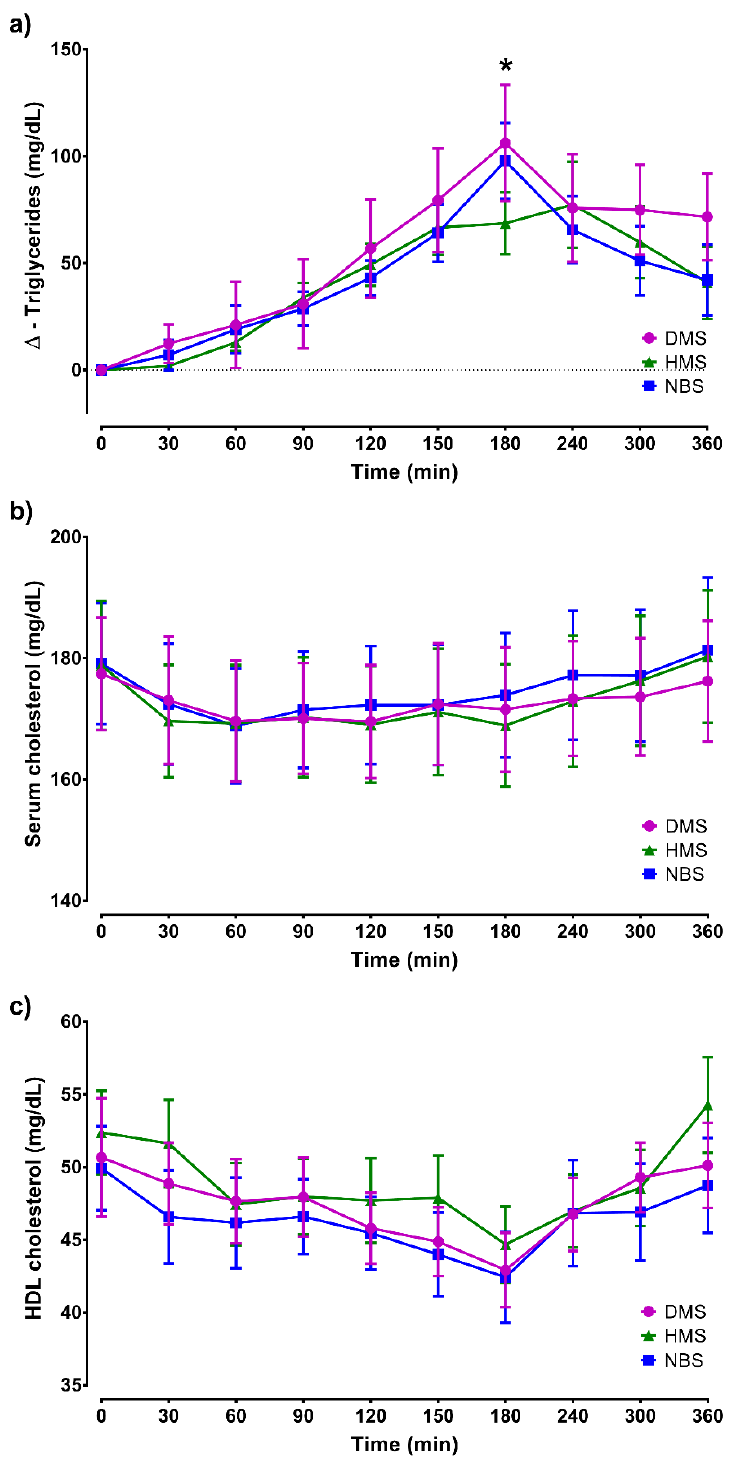
Figure 3. Postprandial lipemic responses: (a) triglycerides, (b) cholesterol, and (c) HDL cholesterol. Basal concentrations and following ingestion of breakfast and treatments are shown. Data are expressed as mean ± SEM ( n = 14). The triglyceride values are expressed as Δ -TG. Comparisons are based on two-way repeated-measures ANOVA and the Tukey post-hoc test. * p < 0.05, HMS vs. DMS.